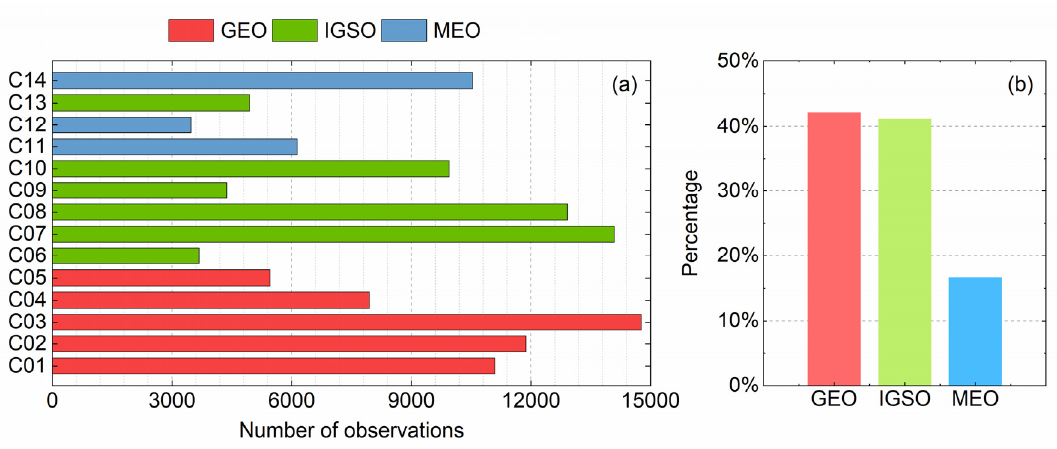
Figure 2. Statistics of BDS observations. ( a ) The number of observations for BDS satellites. ( b ) The percentage of different BeiDou satellite types.